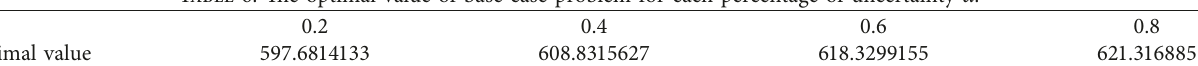
Table 6: The optimal value of base case problem for each percentage of uncertainty α